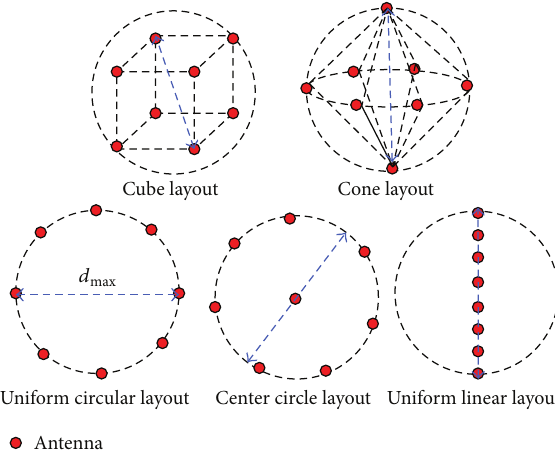
Figure 2: Reference regular antenna